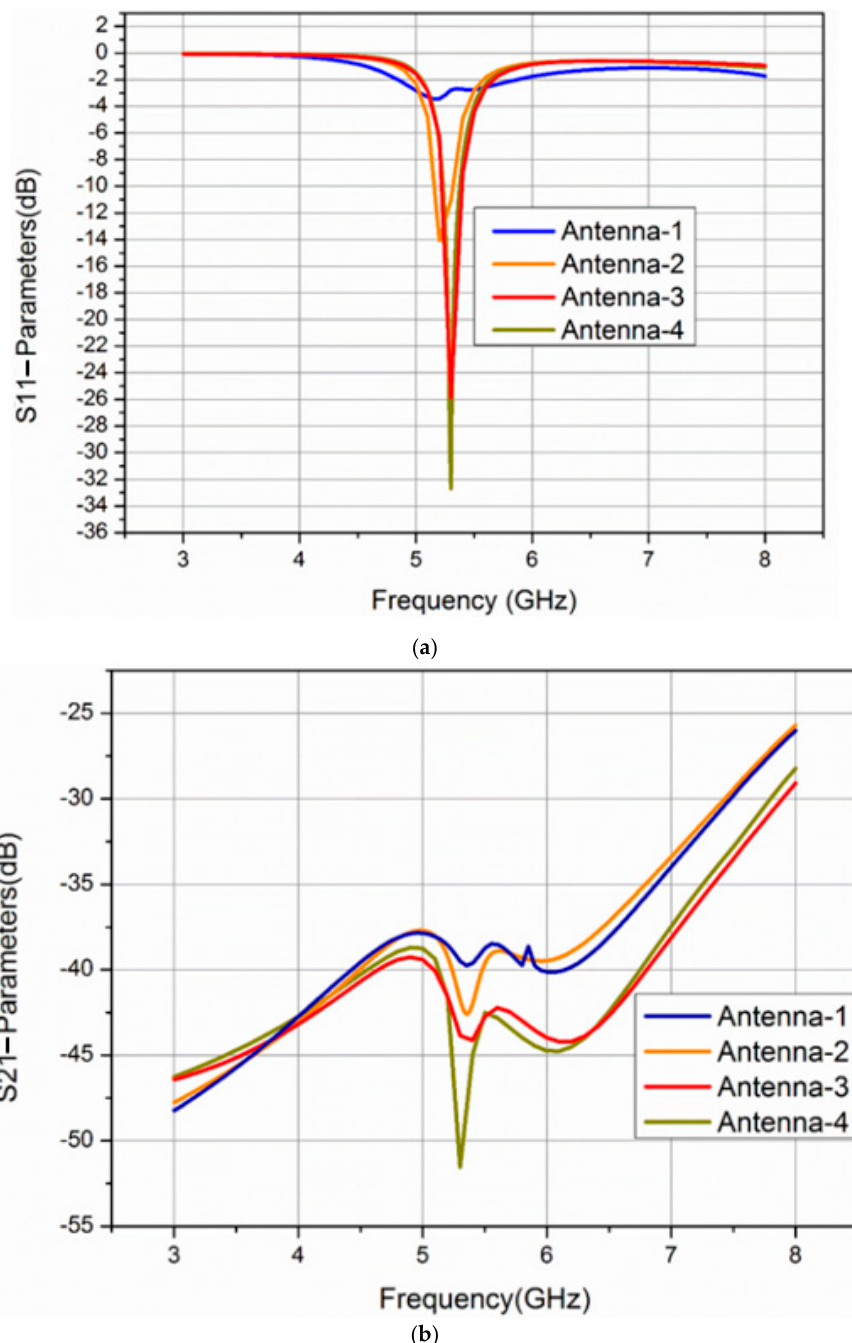
Figure 4. ( a , b ) Simulated S-Parameters of Antenna-1, Antenna-2, Antenna-3, and Antenna-4.